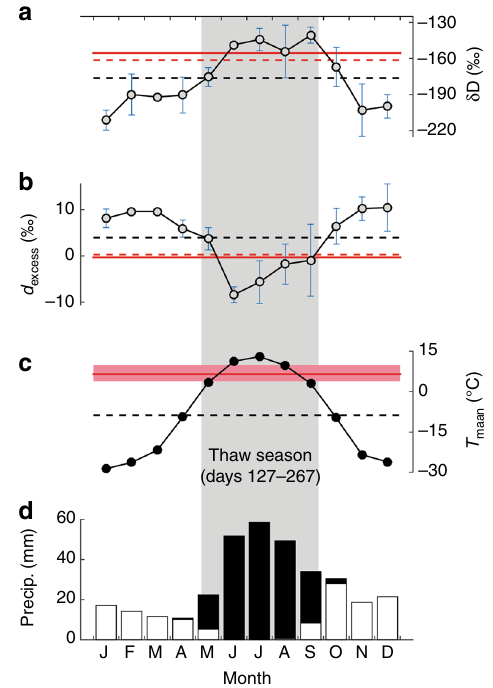
Fig. 3 Co-isotope plot of local GNIP (Global Network of Isotopes in Precipitation) data and δ pore ice . a Mayo GNIP data (grey circles) used to constrain the Local Meteoric Water Line (LMWL; excluding any leverage points marked with a square and likely evaporation-enriched data points marked with red crosses) and the composite DHP174 (Dempster Highway Peatland, near 174 km marker) δ pore ice record ( δ seawater -corrected — as in Fig. 2d, e); δ pore ice data points are colour coded by age classes >9.2 ka BP (blue circles), 9.2 – 5 ka BP (yellow circles) and <5 ka BP (red circles); b enlarged inset (as shown in subplot ‘ a ’ ) with separate regression lines for the LMWL (black), and early Holocene (>9.2 ka cal BP; blue) and lower active layer before the permafrost table aggrades 1 cm, thereby trapping pore ice situated at the former permafrost table as constrained by ALT max . While ALT max will not be reached every thaw season (Supplementary Note 1), it is the infrequent,